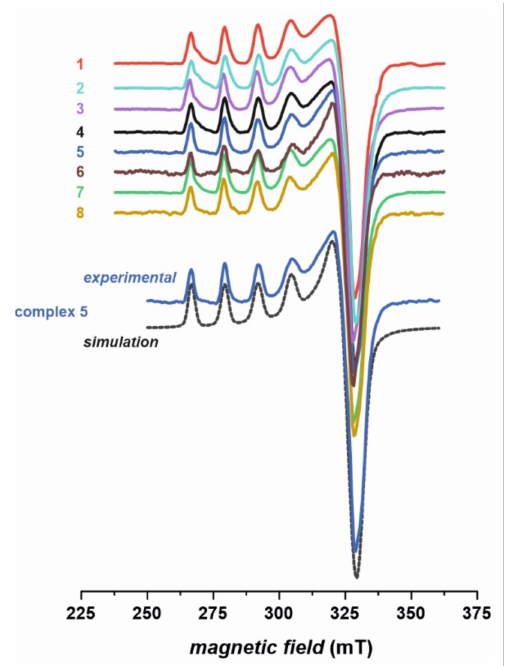
Figure 4. Frozen solution (77 K) X-band electron paramagnetic resonance (EPR) spectra of complexes 1 – 8 , along with exemplary computer simulation of spectrum for the complex 5